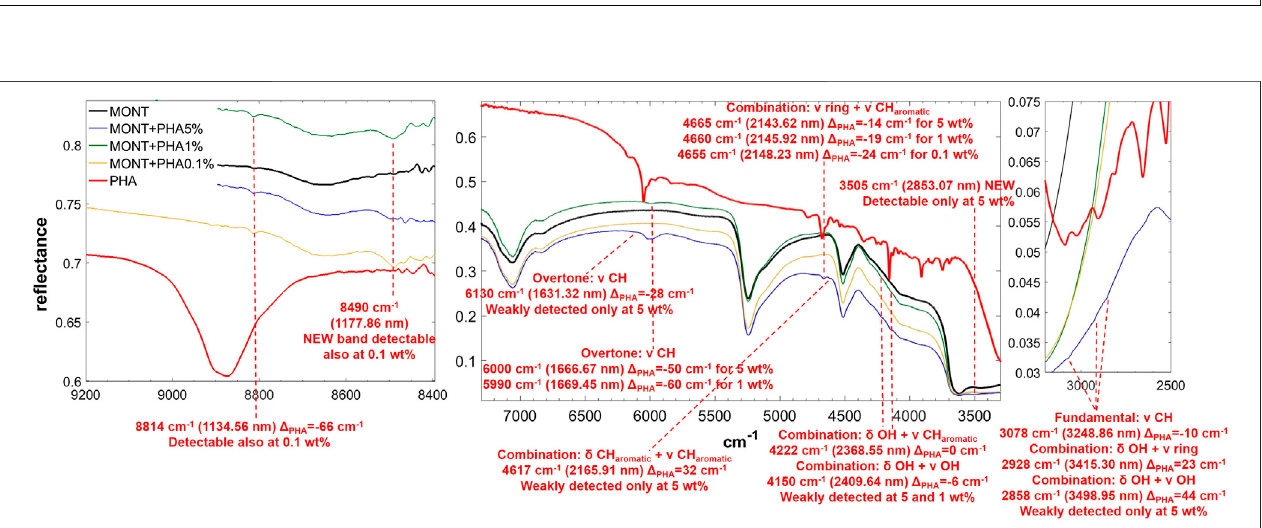
FIGURE6| NIRspectraofPHAadsorbedonmontmorilloniteat5,1,and0.1 wt%concentration.Legend: Δ PHA (cid:2) wavenumbershiftwithrespecttothesamepeak of the pure molecule in the solid state; ν (cid:2) stretching vibrational mode; δ (cid:2) bending vibrational mode.